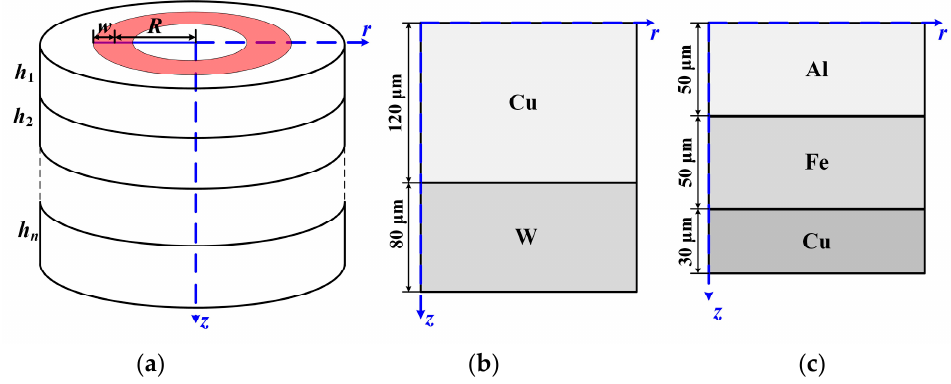
Figure 5. Schematic diagram of the simulation model: ( a ) 3D view; ( b ) half cross-section view of the Cu-W bi-layer plate; ( c ) half cross-section view of the Al-Fe-Cu three-layer plate. The red zone represents the laser irradiated area.